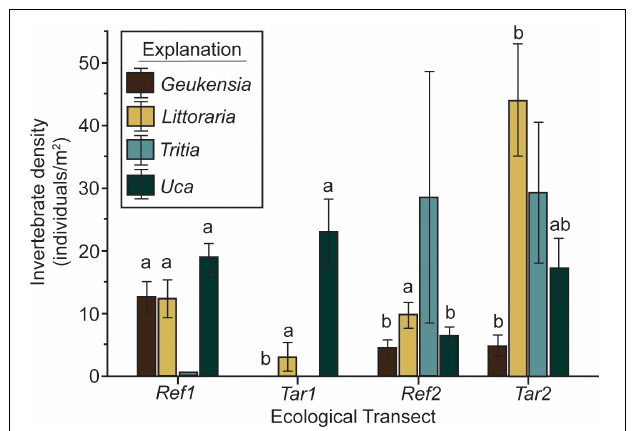
FIGURE 9 | Results of invertebrate surveys from each reference ( Ref1 , Ref2 ) and project ( Tar1 , Tar2 ) marsh and tidal flat ecologic transects (see location: Figure 4B ). Letters above bars denote significantly different groups in Tukey’s post hoc